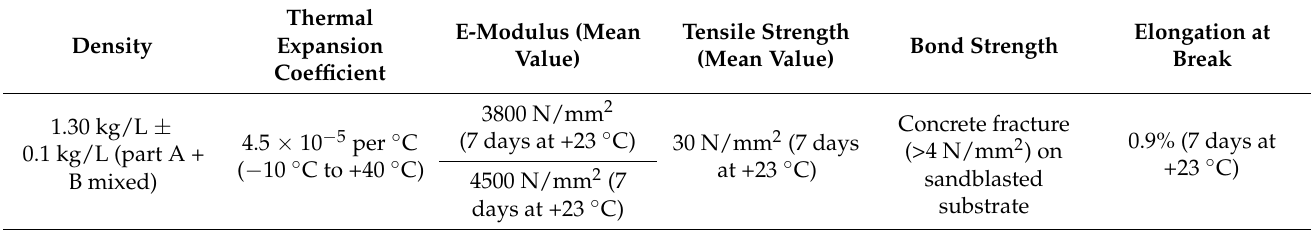
Table 2. Technical data of the epoxy resin.